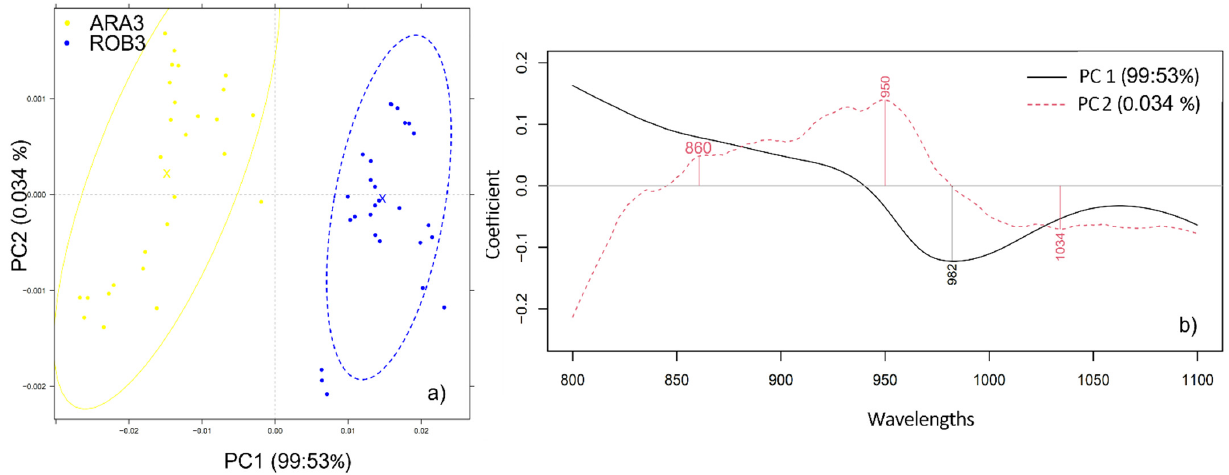
Figure 5. a ) PCA analysis applied to the spectra of pure Arabica (ARA3) and Robusta (ROB3) liquid extracts in the 800–1100 nm range, N = 54 , spectral pretreatment: Savitzky-Golay smoothing (win- extracts in the 800–1100 nm range, N = 54, spectral pretreatment: Savitzky-Golay smoothing (window dow size 19) and MSC; b ) The respective PCA loadings plot. size 19) and MSC; ( b ) The respective PCA loadings